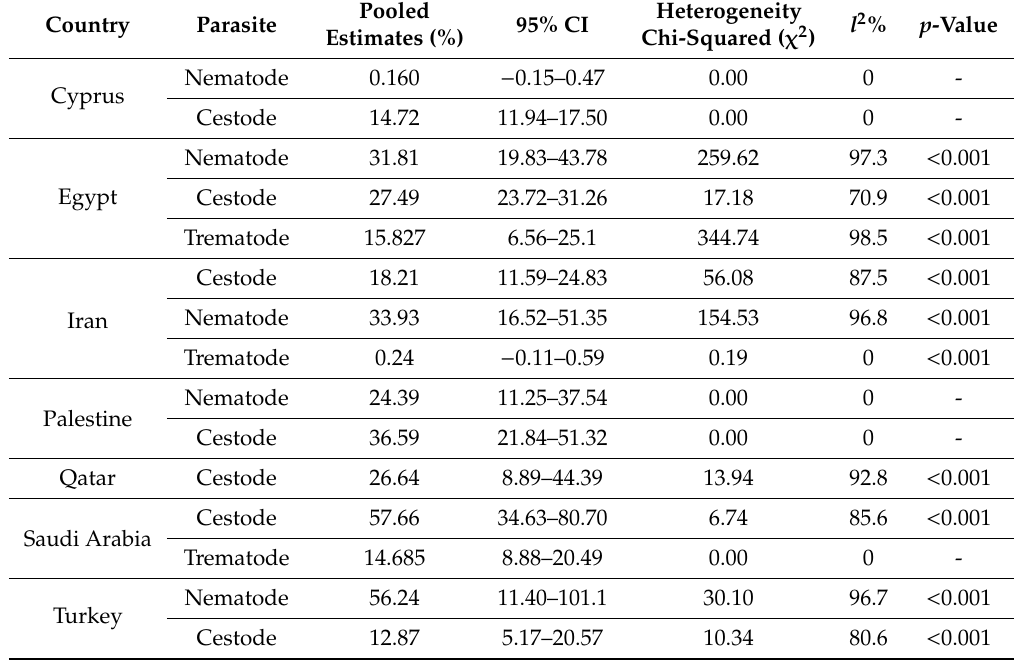
Table 1. Estimated pooled prevalence of the rodent helminths in the Middle East